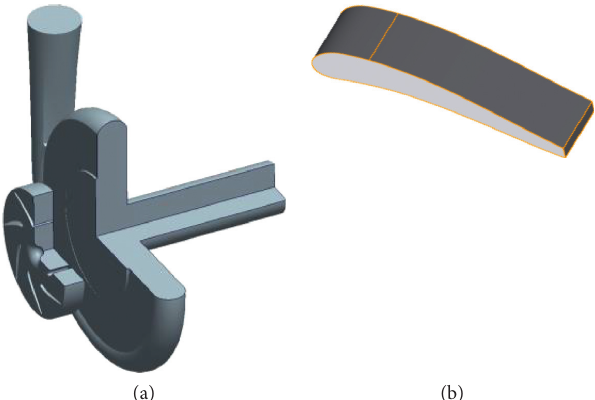
Figure 5: Structure of the vortex pump and blade: (a) impeller and volute and (b) blade.